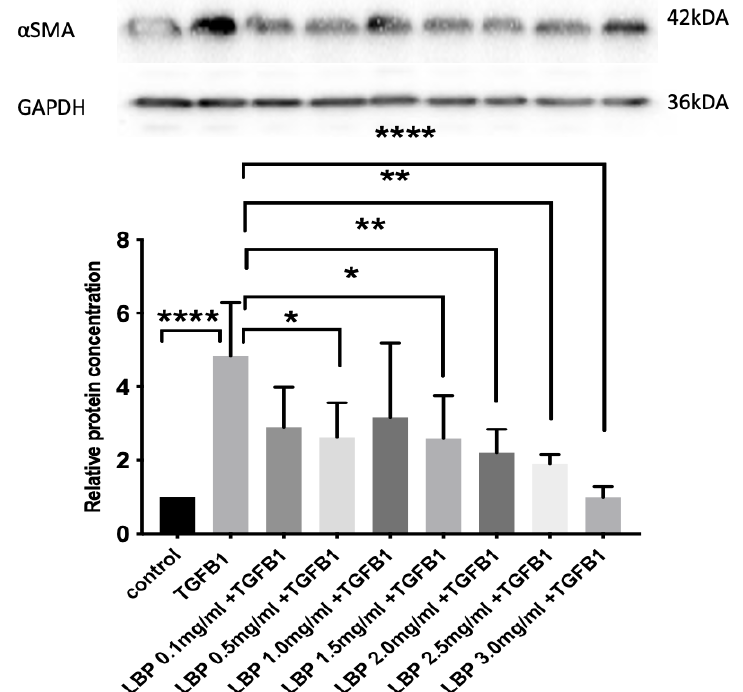
Figure 4. Graph showing α -SMA protein quantification (bottom) with Western blot (top) showing the effect of LBP on α -SMA concentration using one-way ANOVA ( n = 5 for each group), **** p < 0.0001, ** p < 0.01, * p < 0.05.